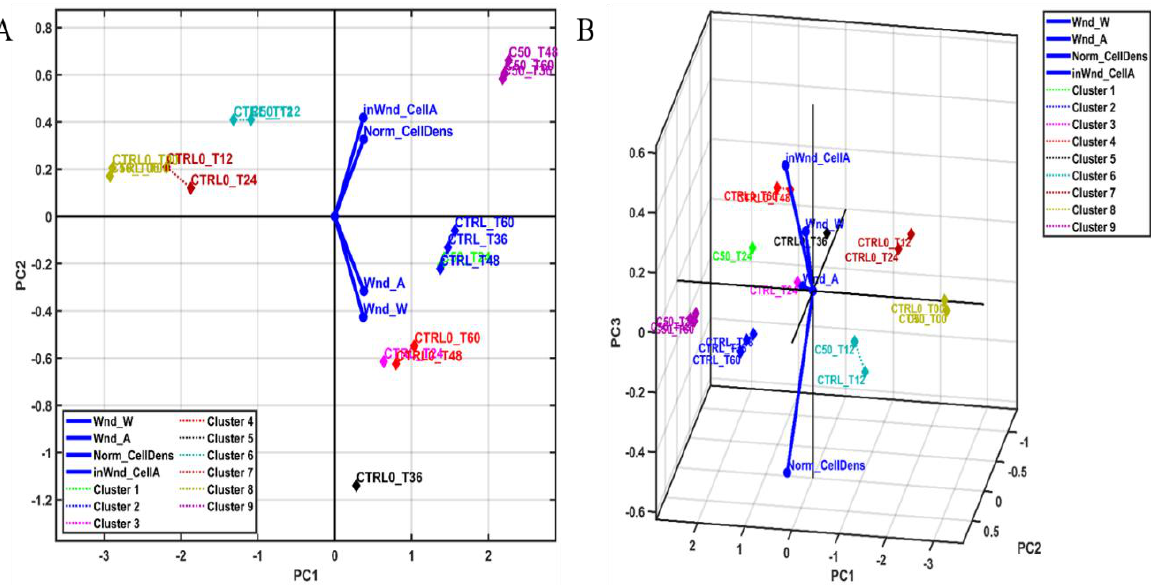
Figure 7. Biplots in original PCA coordinates of MANOVA and AHC results with clusters: ( A ) 2D representation for PC1 and PC2 principal components; ( B ) 3D representation for PC1, PC2 and PC3 principal components.